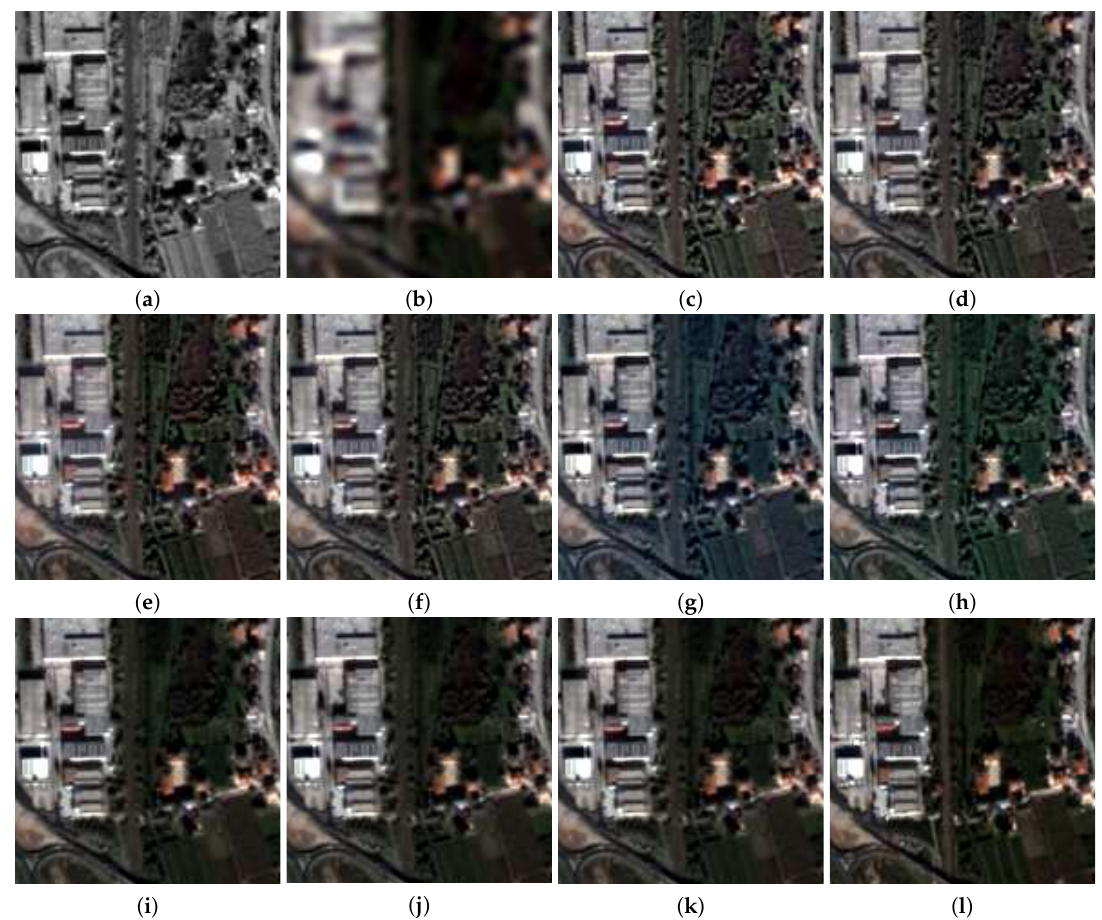
Figure 8. Panchromatic and true-color close-ups of the 2.8 m degraded-scale pansharpened QuickBird Trento for the following methods: ( a ): Pan; ( b ): EXP; ( c ): GS; ( d ): GSA; ( e ): BDSD; ( f ): MTF-GLP-CBD; ( g ): AWLP-Otazu; ( h ): AWLP-Toolbox; ( i ): OBT-H; ( j ): MTF-GLP-HPM-H; ( k ): AWLP-H; ( l ):